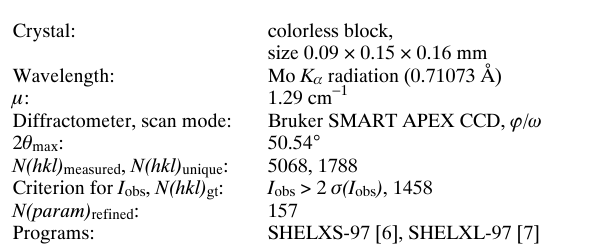
Table 1. D a t a collection a nd h a ndling.